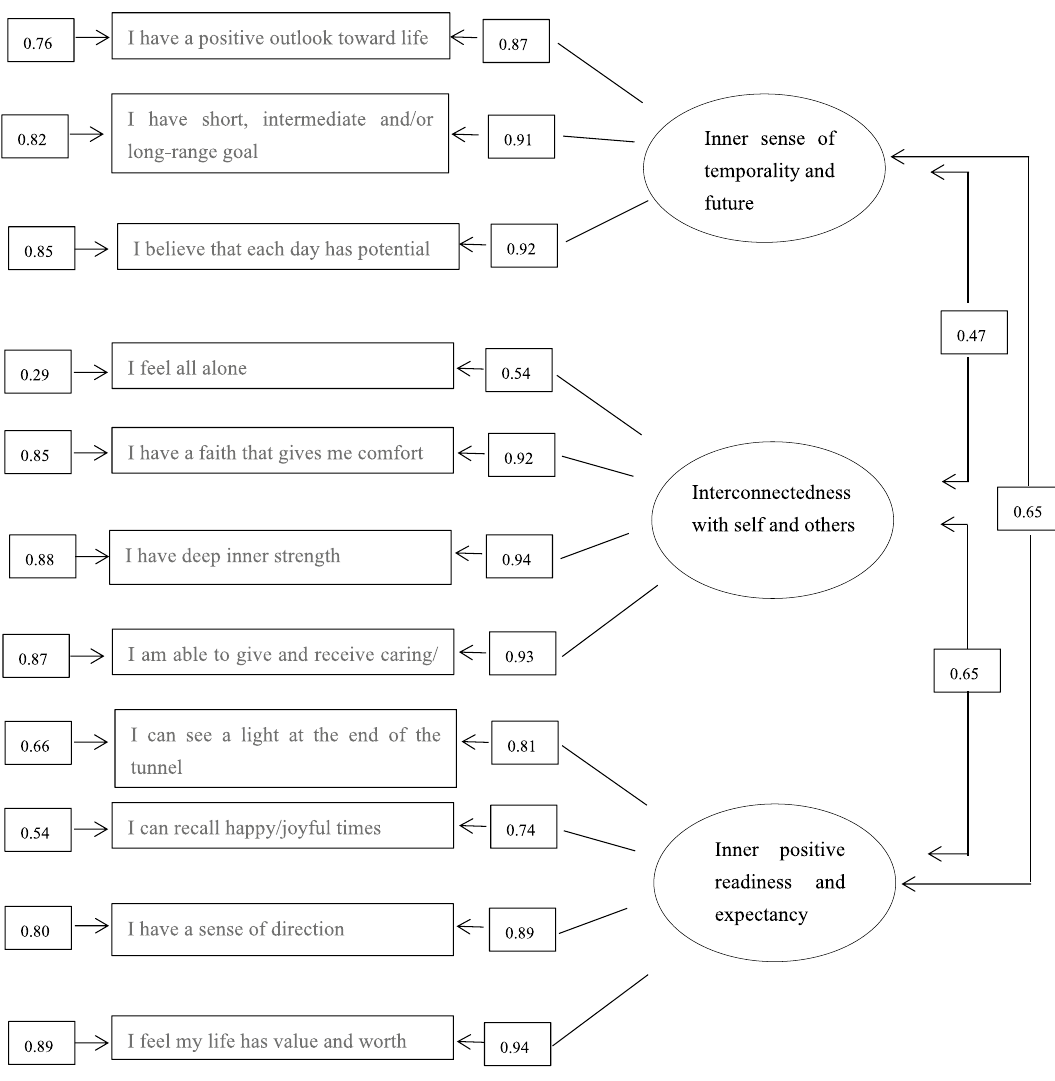
Figure 1. Confirmatory factor analysis for the Chinese version of 11-item 3-factor HHI (n = 206). [Three factors: Inner sense of temporality and future, Interconnectedness with self and others, and Inner positive readiness and expectancy. All the paths were significant in this model ( P < 0.05).]